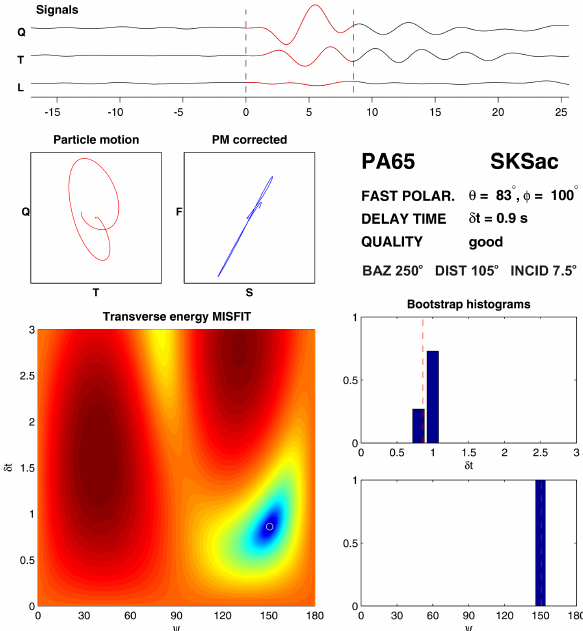
Figure 3. Example of evaluation of SKSac phase splitting at sta- tion PA65 in the central part of the PASSEQ array (see Fig. 2) for an earthquake in the Chile–Argentina border region: 2006-08- 25_00:44, 24.34 ◦ S 67.01 ◦ W, 185km deep, 5.8Mw. Epicentral dis- tance to the station is 105.2 ◦ , back-azimuth 250.0 ◦ and incidence angle 7.5 ◦ . For more details of the method see Vecsey et al.